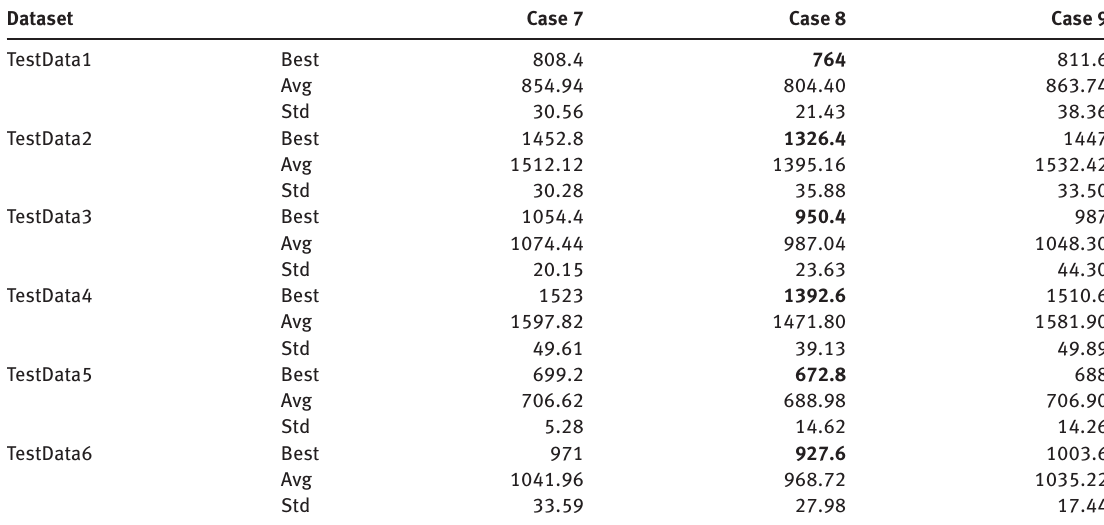
Table 6: Results of Studying HMS Parameter. Dataset